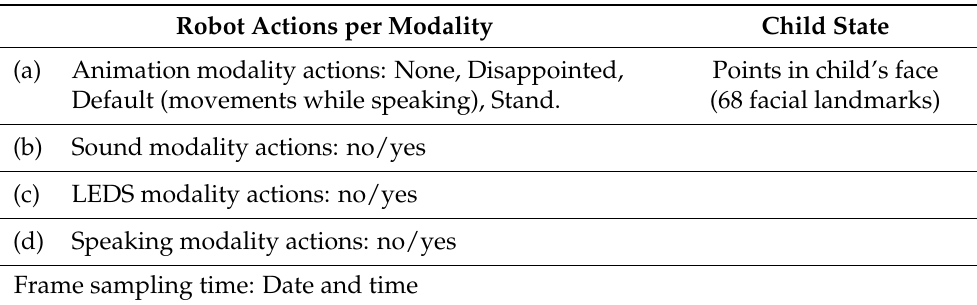
Table 1. A frame with values recorded by NAO robot during a session .